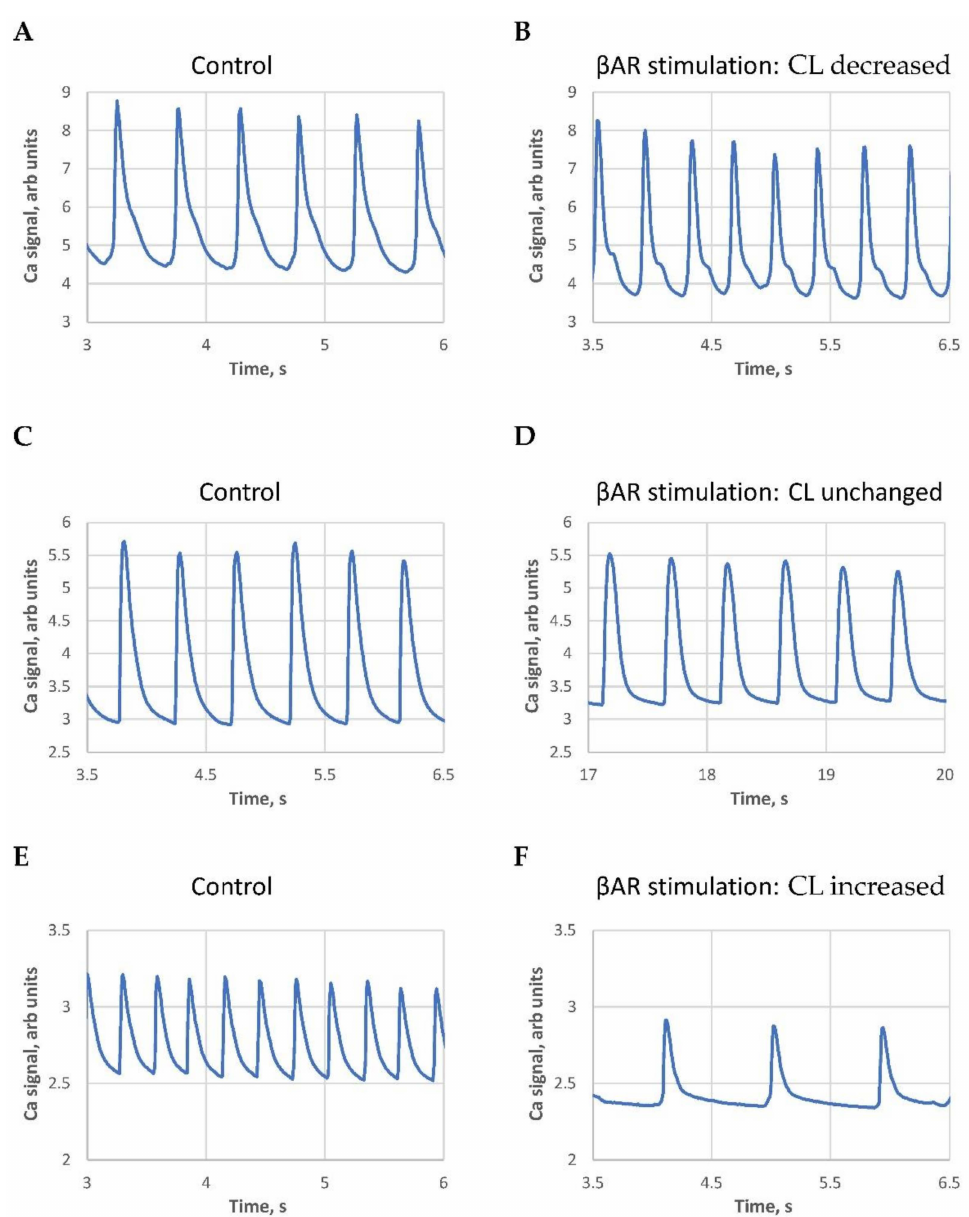
Figure 1. Examples of three types of β AR stimulation effects on AP-induced Ca transient cycle length (CL): ( A , B ): decrease; ( C , D ): no change; and ( E , F ): increase. All traces have the same 3 s duration for clear visual comparison. See also the Videos S1–S6 of cell Ca dynamics in control and in the presence of β AR